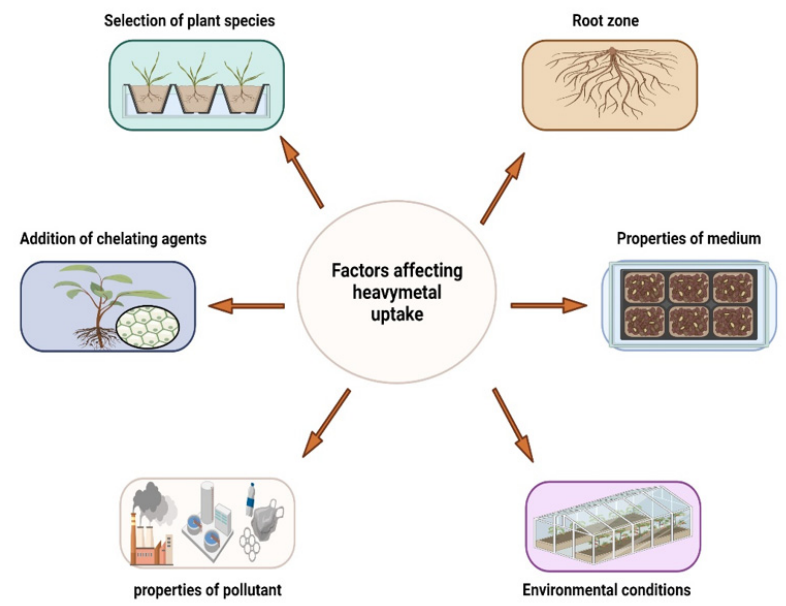
Figure 3. Factors affecting heavy metal